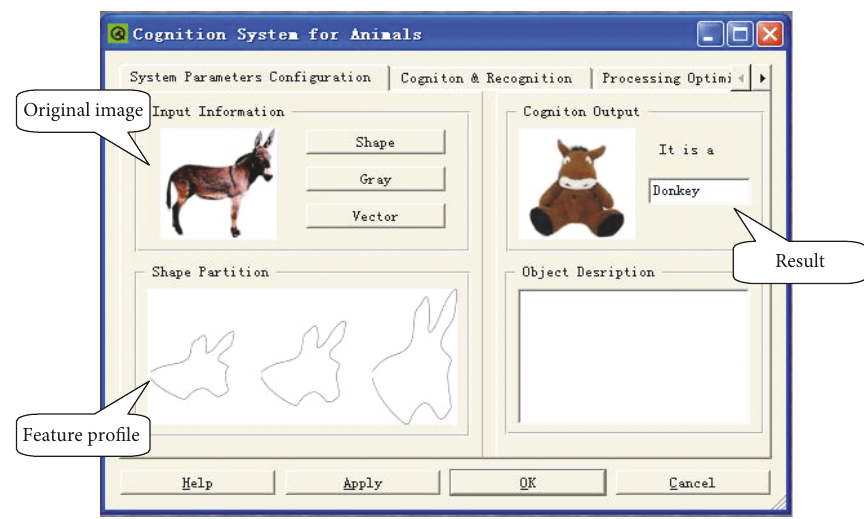
Figure 8: Main control interface of the cognition